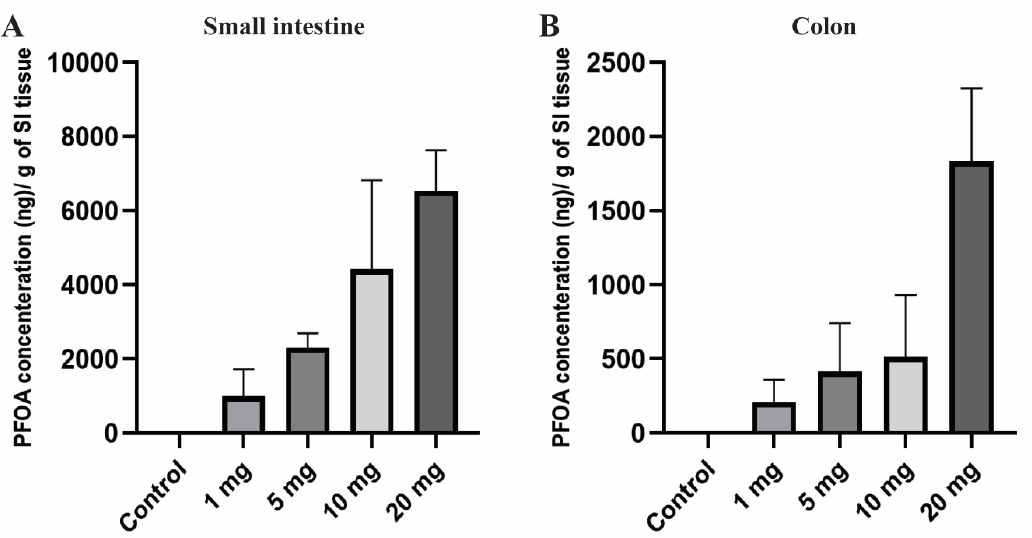
Figure 1. Bioaccumulation of PFOA in the intestinal tissues of CD1 mice. Mice were treated with control (0.5% Tween-20 in water) or 1–20 mg / kg / day PFOA for 10 days. ( A ) Quantification of PFOA in ng / gram in small intestine tissue; ( B ) quantification of PFOA in ng / gram of colon tissue using UPLC chromatography.